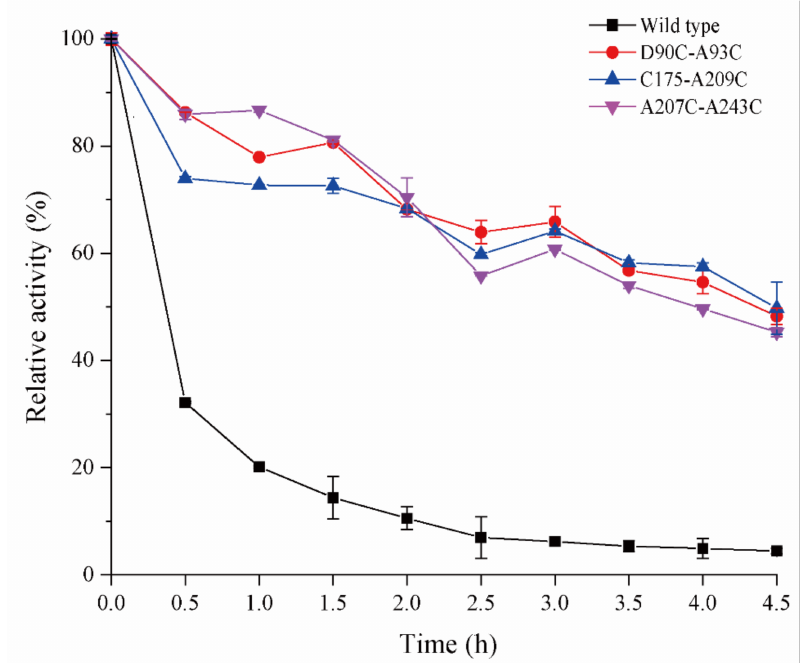
Figure 4. Thermostability of wild type DPEase and the three mutants. Table 2. Characterization of the DPEase from different sources [a]